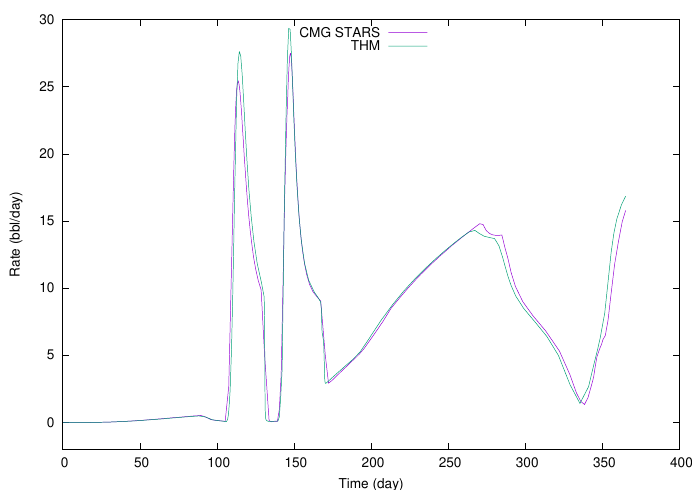
Figure 3. Example 1, water production rate (bbl/day), first production well.